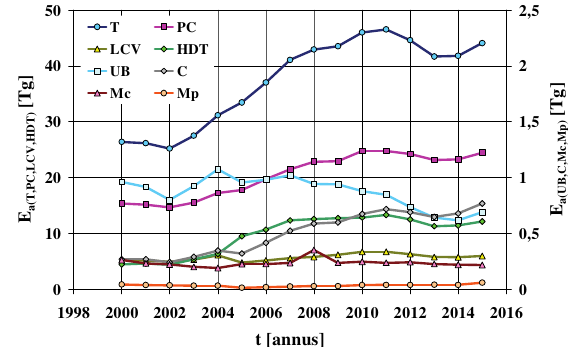
Fig. 14. National annual emission of nitrous oxide per cumulated vehicle category